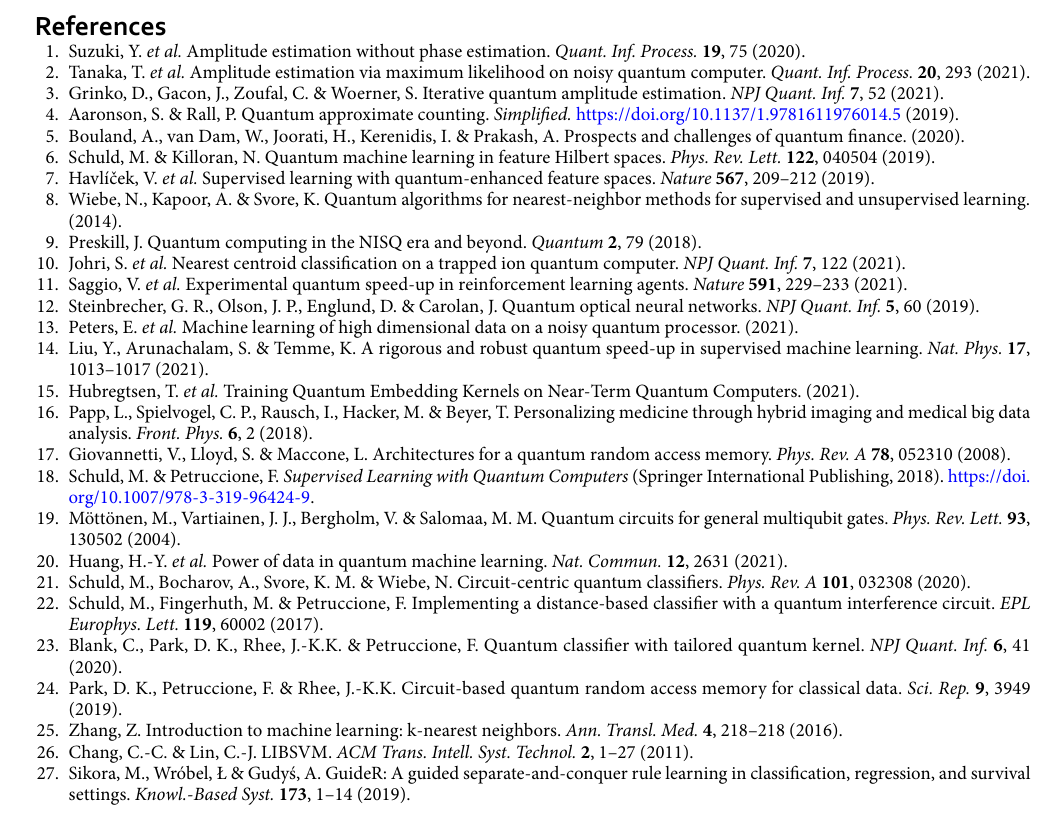
O O where is the noisy expectation value and is the noiseless expectation value 41 . (cid:31) (cid:30) (cid:31) (cid:30) Data availability The source code of the implemented quantum algorithms can be accessed by the link: https:// github. com/ sassa n72/ Quant um- Machi ne- learn ing. For classical machine learning executions, this study relied on the scikit-learn library 38 : https:// scikit- learn. org/ stable/. All included open-access datasets are accessible through the following links: Pediatric bone marrow transplant dataset 27 : https:// archi ve. ics. uci. edu/ ml/ datas ets/ Bone+ marrow+ trans plant% 3A+ child ren. Wisconsin breast cancer dataset 28 : https:// archi ve. ics. uci. edu/ ml/ datas ets/ Breast+ Cancer+ Wisco nsin+ (Diagn ostic). Heart failure dataset 29 : https:// www. kaggle. com/ andre wmvd/ heart- failu re- clini cal- data.